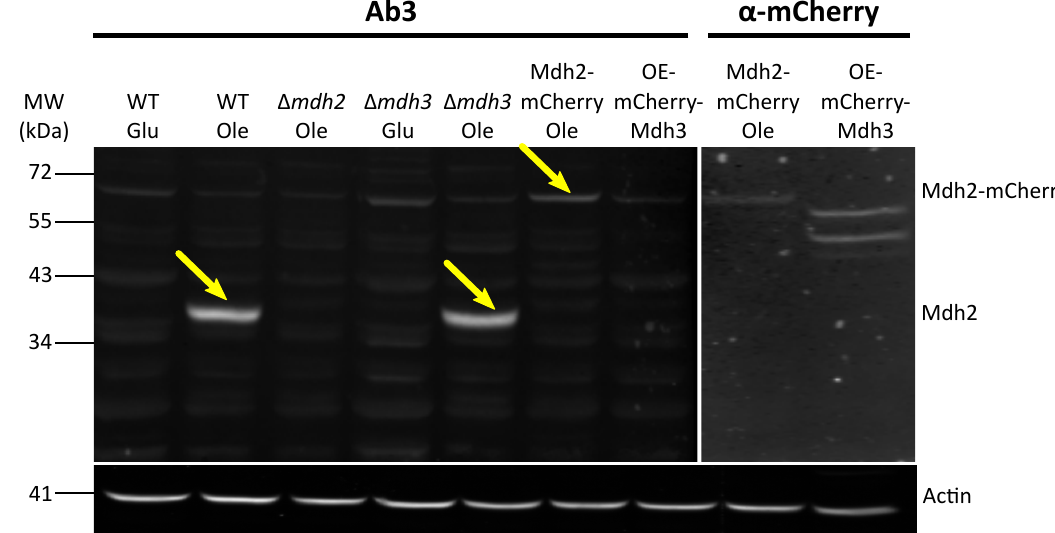
Figure 3. Antibody 3 has the best specificity to Mdh2. Western blot analysis was done on protein extractions from different strains grown on oleic acid (Ole) or glucose (Glu) (OE-mCherry-Mdh3 was grown in glucose) using antibody 3 and anti-mCherry. Similarly to antibody 2, antibody 3 does not recognize Mdh2 in Δ mdh2 strain or in cells grown on glucose. This antibody has a good specificity to Mdh2, as seen by the low background signal. Actin was used as a loading control. Yellow arrows indicate bands corresponding to Mdh2. (OE = over